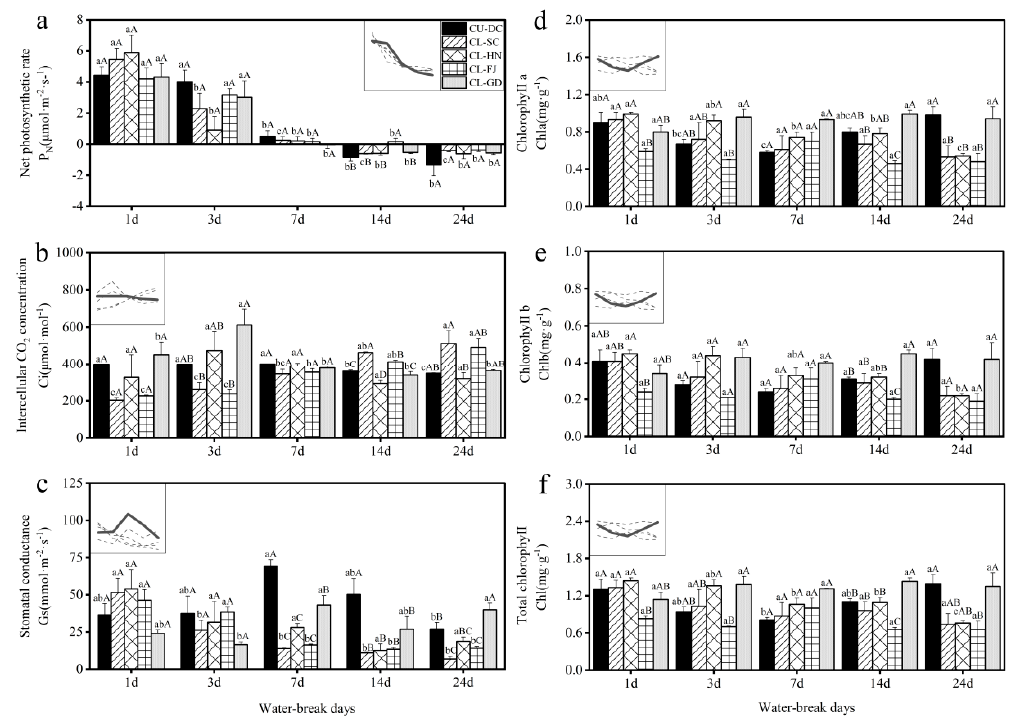
Figure 3. ( a ) net photosynthetic rate ( P N ), ( b ) intercellular CO 2 concentration ( Ci ), ( c ) stomatal conductance ( Gs ), ( d ) chlorophyll a ( Chla ), ( e ) chlorophyll b ( Chlb ) and ( f ) total chlorophyll ( Chl ) of C. unica and C. lanceolata leaves under di ff erent water − break days.